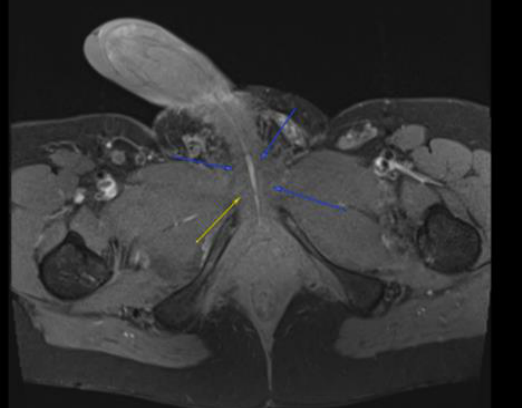
Figure 3. MRI in the axial view T1 TSE FS PRE showing hyperintense linear non-enhancing structure consistent with ultrasound finding of thrombosed dorsal penile veins.